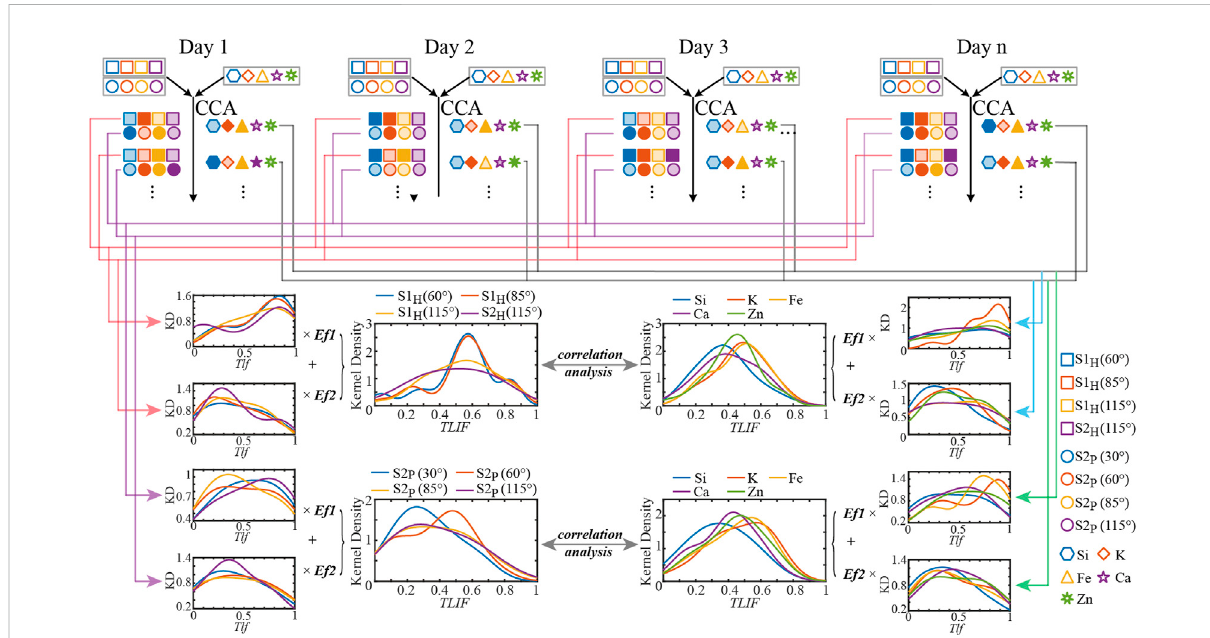
FIGURE 2 Schematic diagram of PCCA. CCA, canonical correlation analysis; KD, kernel density; Tlf , typical load factor; Ef , explanatory factor; TLIF , typical load interpretation